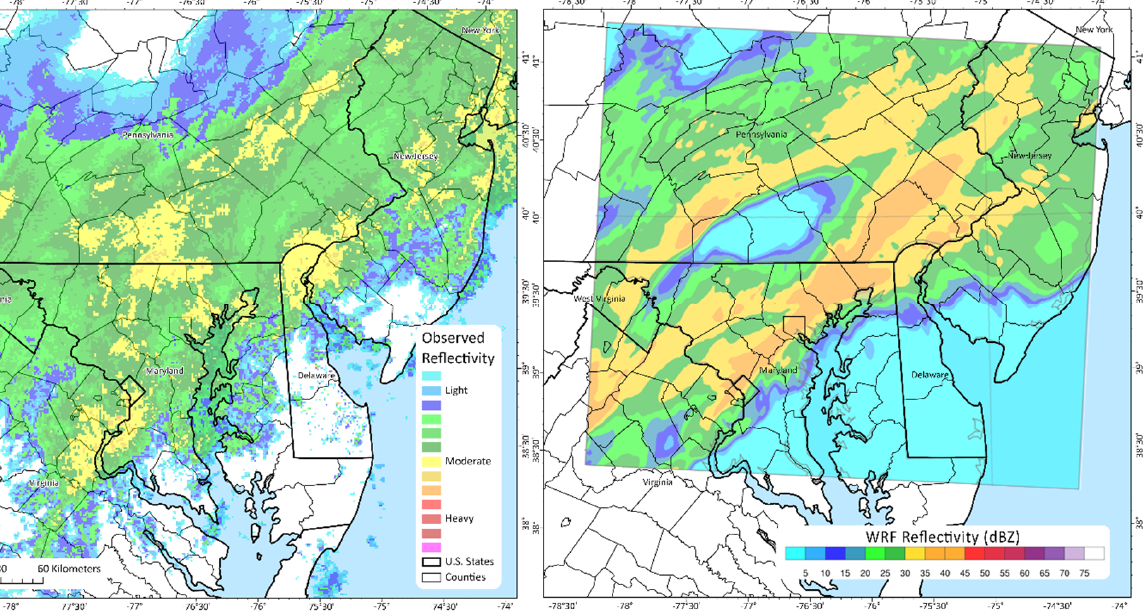
Figure 5. Observed domain Doppler ( left ) and WRF-simulated, control ( right ) reflectivity (dBZ) at 1800 UTC on 6 February 2004. Observed data courtesy of Iowa Environmental Mesonet.